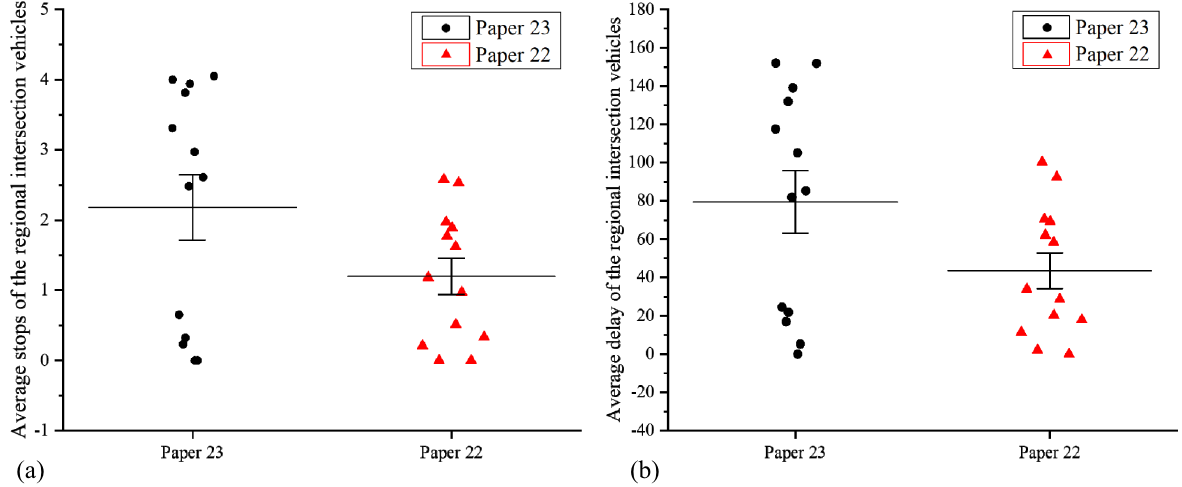
Figure 8. Comparison of control effects. ( a ) Average stops of the regional intersection vehicles, ( b ) Average delay of the regional intersection